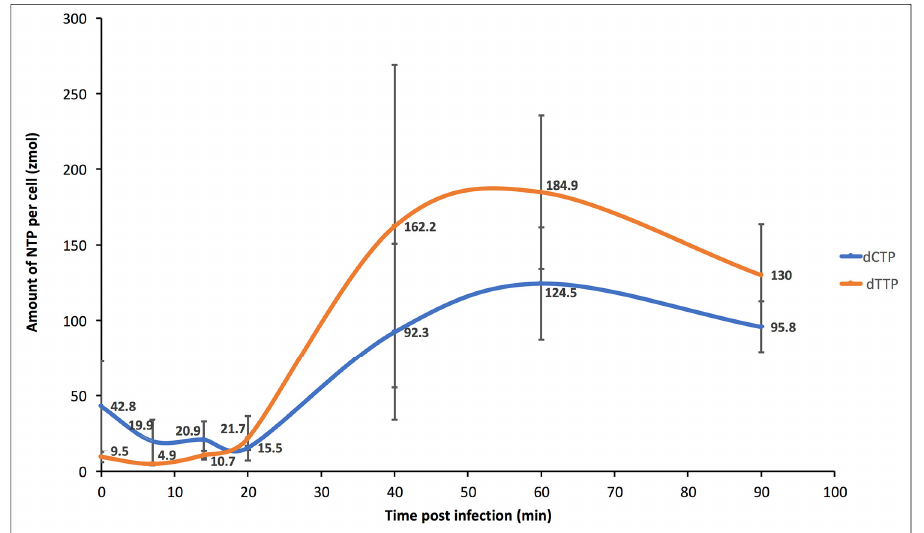
Figure 3. Chart of dCTP and dTTP amounts per cell post infection time. Values represent the mean of three biological replicates. The standard deviation values were at, 0 min post infection time (p.i), 30 and 3.5; at 7 min p.i., 14 and 1; at 14 min p.i., 12.1 and 2.8; at 20 min p.i., 1.5 and 14.7; at 40 min p.i., 58.4 and 107; at 60 min p.i., 37.2 and 50.8; at 90 min p.i., 16.9 and 33.8, for dCTP and dTTP, respectively. A secondary early phase (t = 20 to 60 min p.i.) indicates that uridine and UMP change little, but the extent of change was highly significant in terms of resourcing the pyrimidine biosynthesis pathway. These two metabolites were three orders of magnitude greater than the next most abundant metabolites that we measured in the pyrimidine biosynthesis pathway. Thus, small percentage changes in these two compounds will result in large percentage changes downstream. Uridine increased with time, indicating an influx, likely via uracil from the alanine/aspartate metabolism pathway and the beta-alanine metabolism pathway. UMP decreased early but began to recover by 60–90 min p.i. This suggests there is a delay in flux from uridine, while there is a pull via UDP deoxynucleoside kinase (E.C. 2.7.4.14; PBCV1_A416R) (Figure 1E). The measured fluxes appear to derive from a high abundance of uridine and UMP, each at >10 6 zmol/cell (Figure S1C, Panels III and IV). Surprisingly, two intermediates were measured but not detected throughout the infection: N-carbamoyl-L-aspartate and dUTP. This is consistent with a high flux rate of this substrate but apparently not influenced by infection. The flux rate for thymidine and derivative nucleotides increased by 14 min p.i., before other intermediates started to increase (Table 2) At 40 min p.i., uridyl-nucleotides remain suppressed, while cytidine and thymidine nucleotides are significantly above the initial state. At 60 min p.i., all pyrimidine nucleotides were above the initial state.